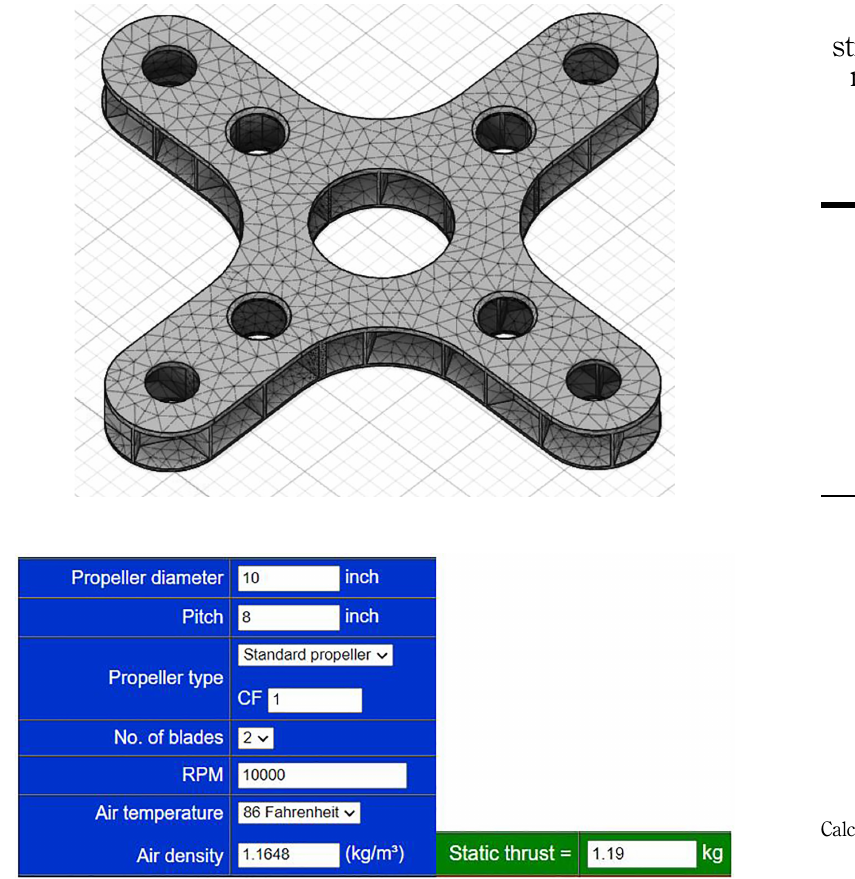
Figure 9. Calculator to determine the static